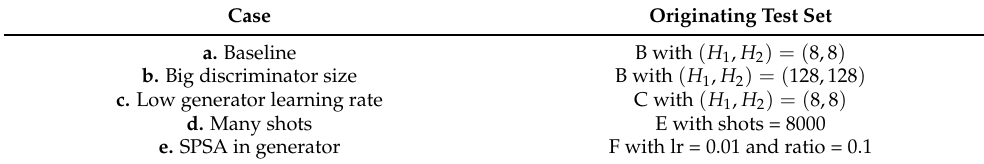
Table A2. Test cases used in Section 4.4 are selected from tests in Table A1.